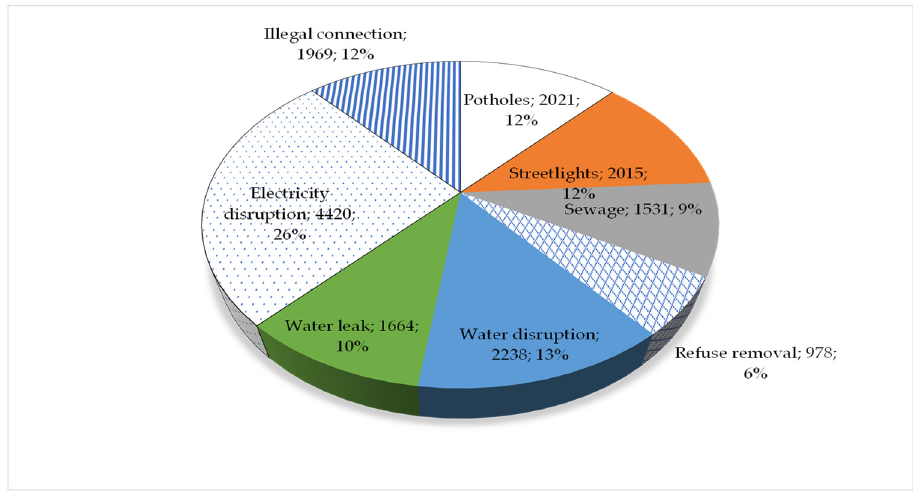
Figure 3. Municipalities service delivery matters as reported on the GovChat platform, South Africa. Table 2. Municipal infrastructure reliability by service type in South